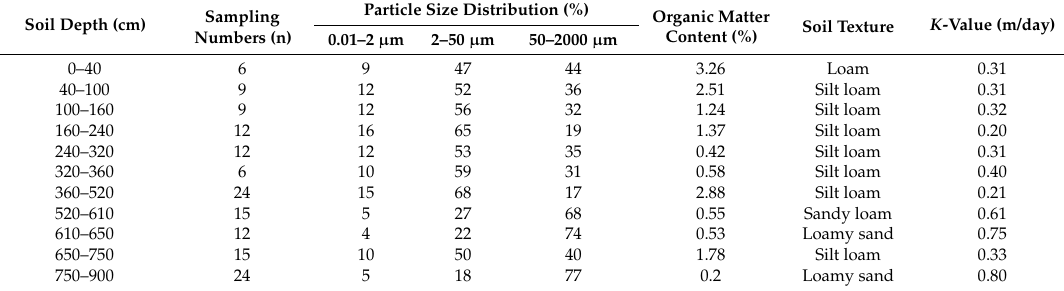
Table 1. Particle size distribution and organic matter content in the soil profile at the monitoring site. Soil Depth